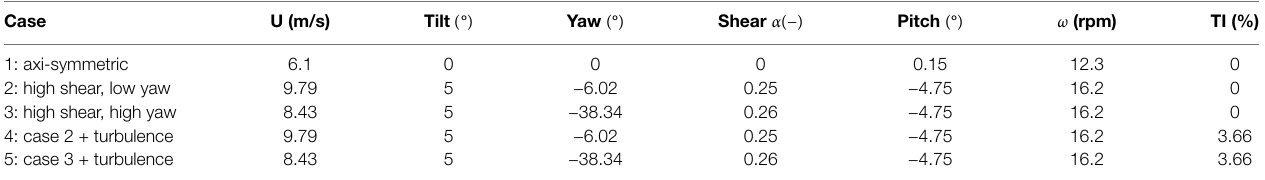
TABLE 1 | Simulation Cases. Pitch is defined as positive when decreasing the angle of attack. Yaw is defined as positive when the turbine rotates clockwise as seen from above ( i.e. the blades rotate towards downstream from the top position).